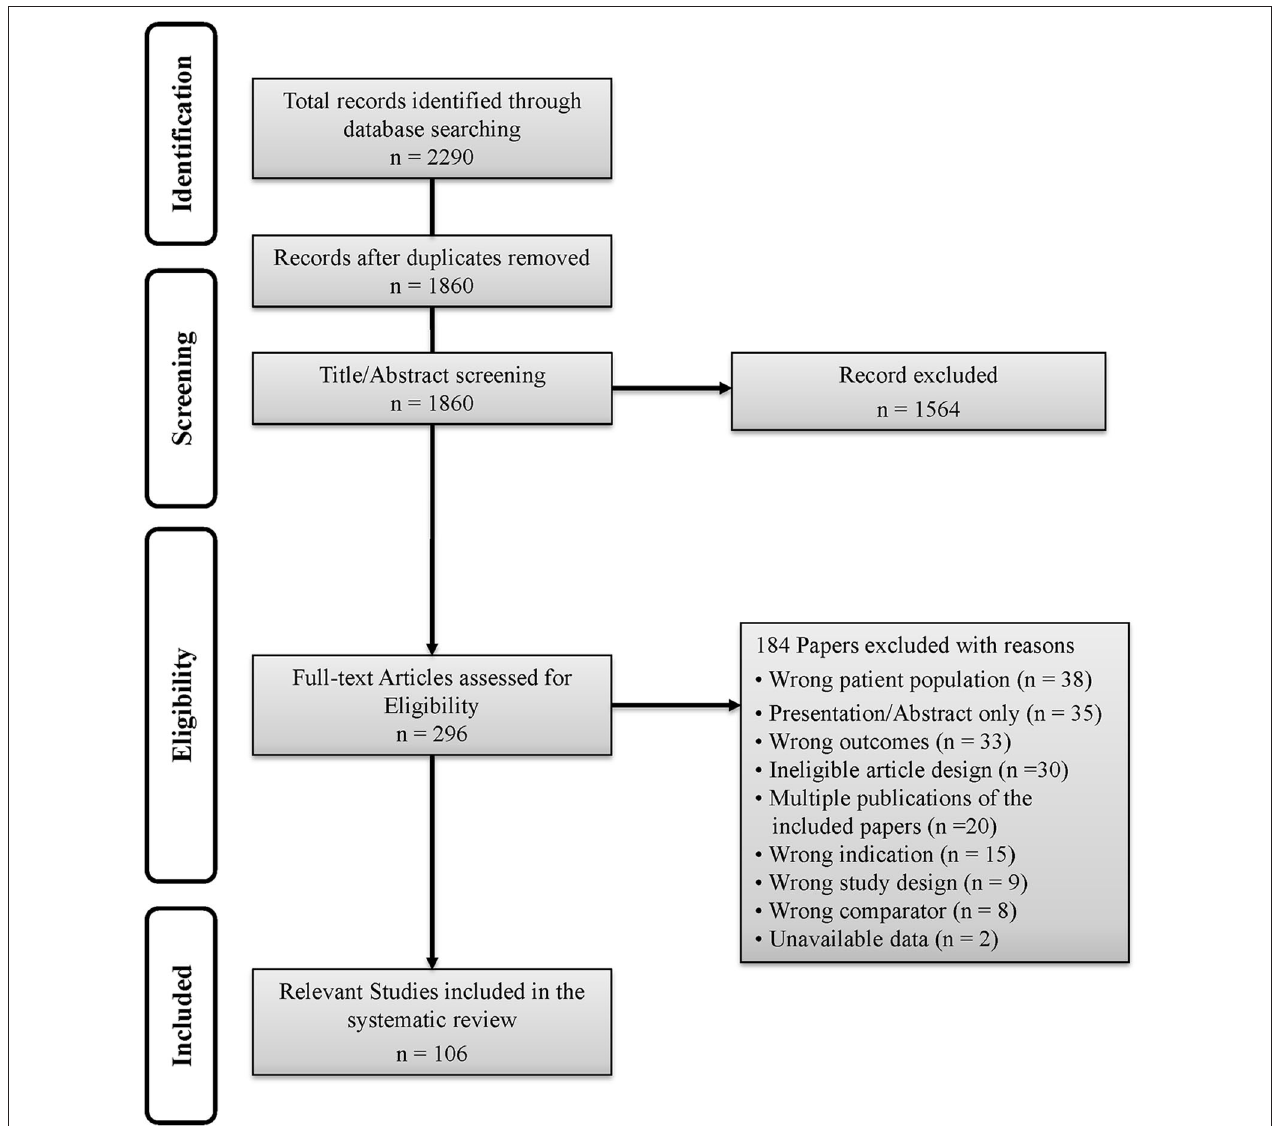
FIGURE 1 | PRISMA